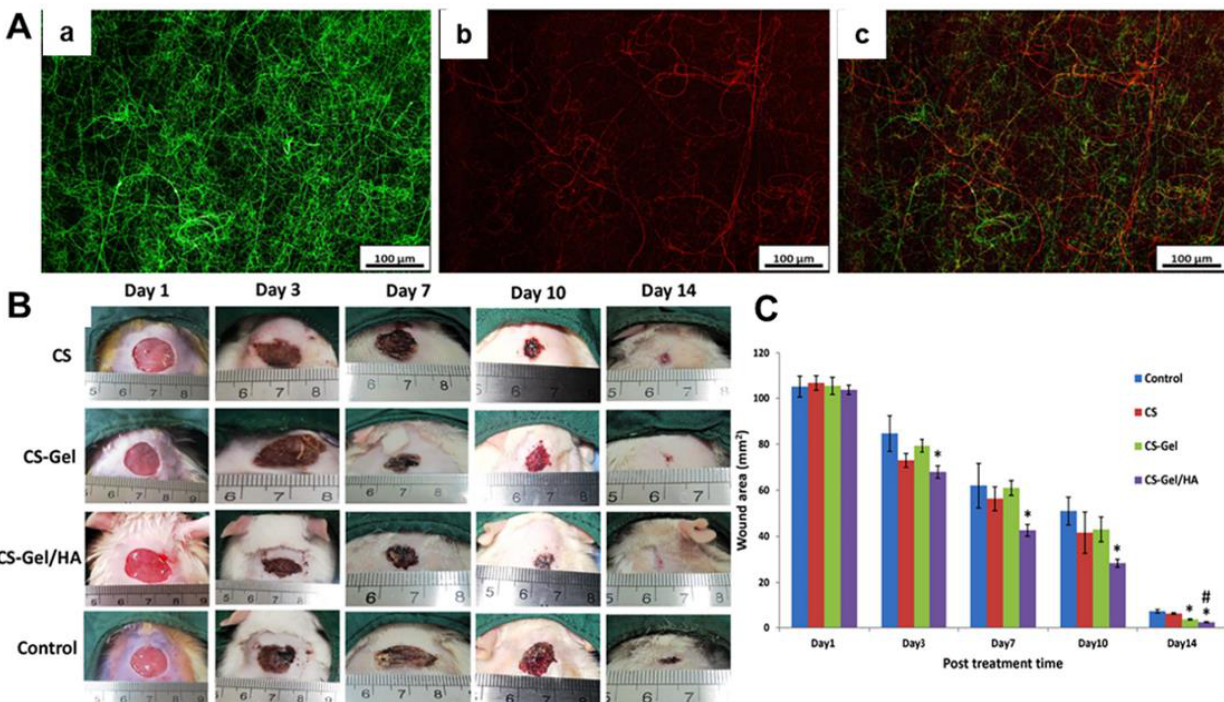
Figure 5. Design and development of composite wound dressings containing both CS-gelatin (Gel) nanofibers and CS-HA nanofibers. ( A ) Fluorescent images of ( a ) CS-Gel nanofiber mats with green color, ( b ) CS-HA nanofiber mats with red color and ( c ) merged CS-Gel/CS-HA nanofiber mats. ( B ) Photographs of wound-healing process using different dressings, i.e., CS nanofiber mats, CS-Gel nanofiber mats, CS-Gel/HA nanofiber mats, and medical gauzes (Control). ( C ) Statistical analysis of wound area of different experimental groups at predetermined time points. * p < 0.05 compared to control. # p < 0.05 compared to CS-Gel group. Reprinted with permission from ref. [129], Elsevier, 2020.